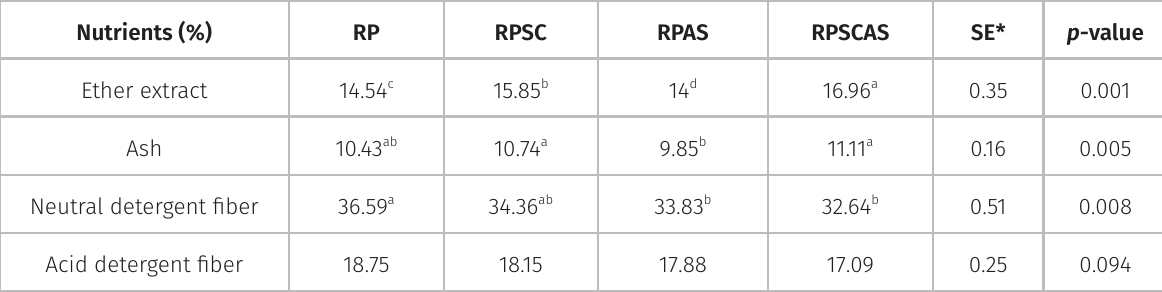
Means in the same row with different superscripts were significantly different from each other. *Standard error . RP, RPSC, RPAS and RPSCAS represent rice polishing, rice polishing plus Saccharomyces culture, rice polishing plus ammonium sulphate and rice polishing plus ammonium sulphate and Saccharomyces culture, respectively.